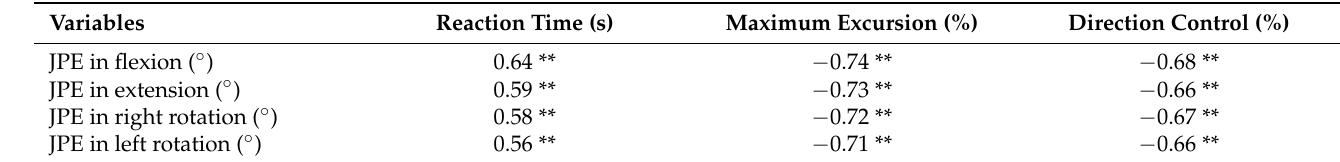
Table 3. Relationship between cervical joint position errors and balance and limits of stability tests ( n = 100).